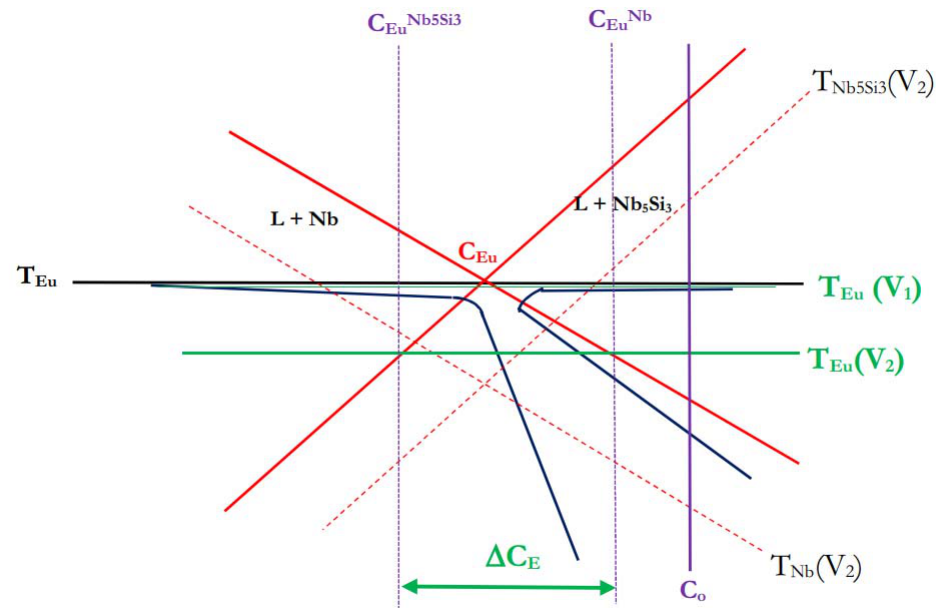
Figure 7. Schematic diagram of the skewed coupled zone of the Nb + β Nb 5 Si 3 metastable eutectic. Red continuous lines show the liquidus of Nb and β Nb 5 Si 3 and dashed red lines the growth temperatures T i (i = Nb, β Nb 5 Si 3 ) dendrites at growth rate V 2 . The black horizontal line is the eutectic temperature T Eu . Drawing based on [37].